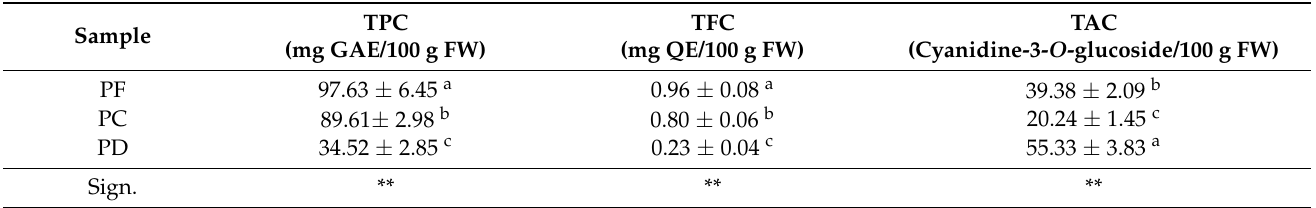
Table 3. Phytochemicals content in the selection of myrobalan bloody pulp fruits